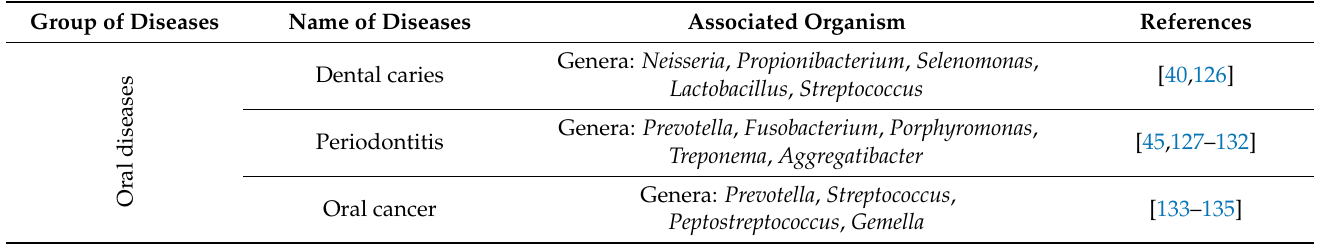
Table 1. Associations between the oral microbiota and oral and systemic